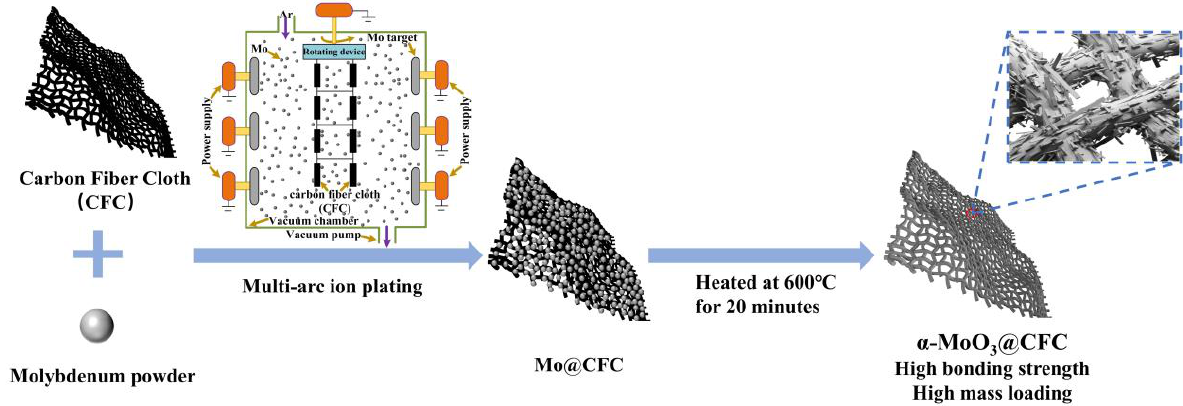
Figure 1. Schematic representation showing the synthesis of α -MoO 3